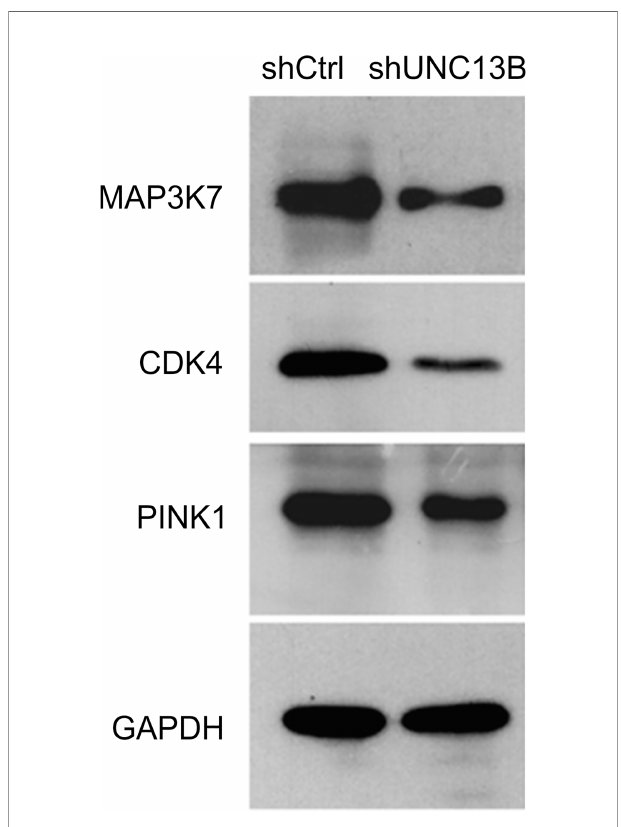
FIGURE 6 | Western blotting analysis of key proteins mediated by UNC13B